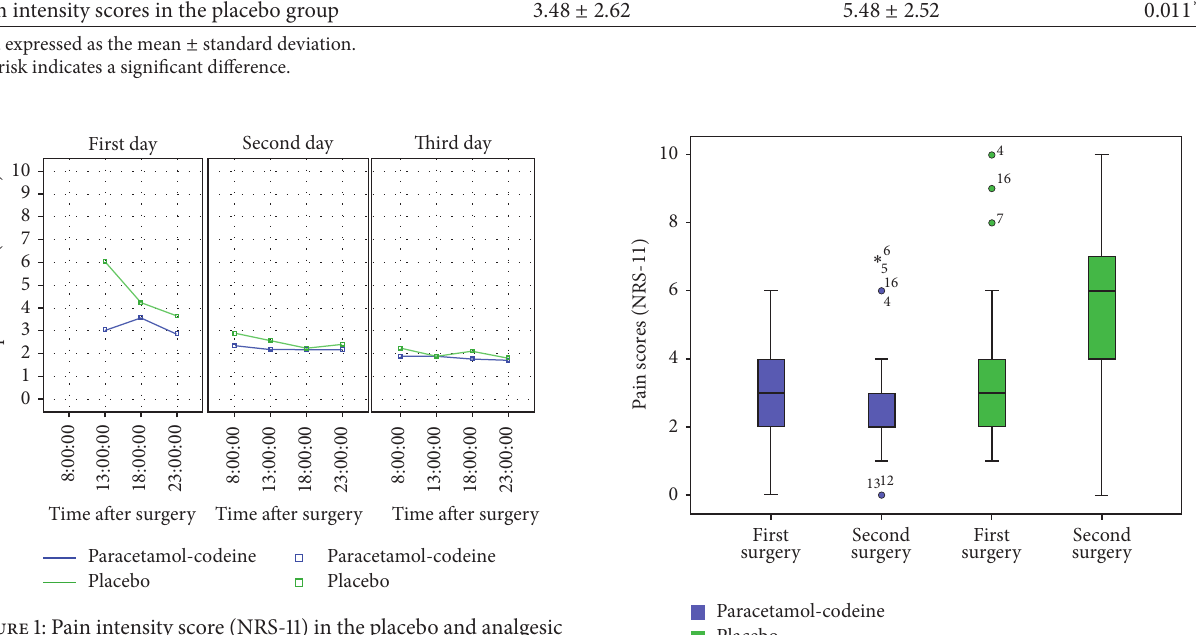
Figure 2: Box-and-whisker plots related to the pain scores (NRS- 11) in patients which received the placebo or analgesic drug, respec- tively, in the first or second surgery. The dark line in the middle of the boxes is the median. The box represents the interquartile (IQ) range which contains the middle 50% of the records. The whiskers are lines that extend from the upper and lower edge of the box to the highest and lowest values which are no greater than 1.5 times the IQ range. The circles are outliers. These are defined as values that do not fall in the whiskers. The asterisks or stars are extreme outliers. These represent cases that have values more than three times the height of the